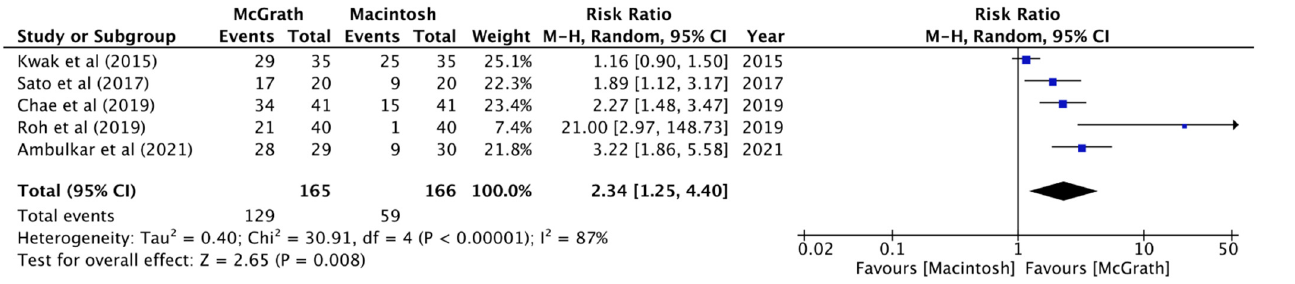
Figure 3. Forest plot of the rate of Cormack–Lehane classification 1 (McGrath vs. Macintosh laryngoscope).